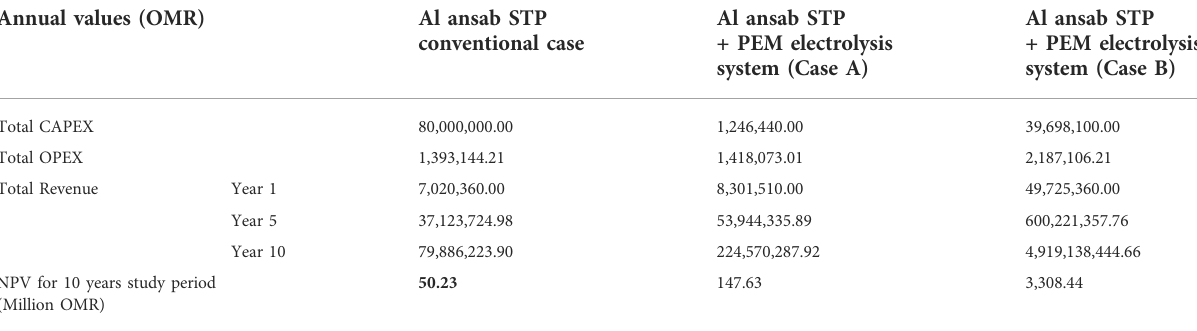
TABLE 7 CBA and NPV